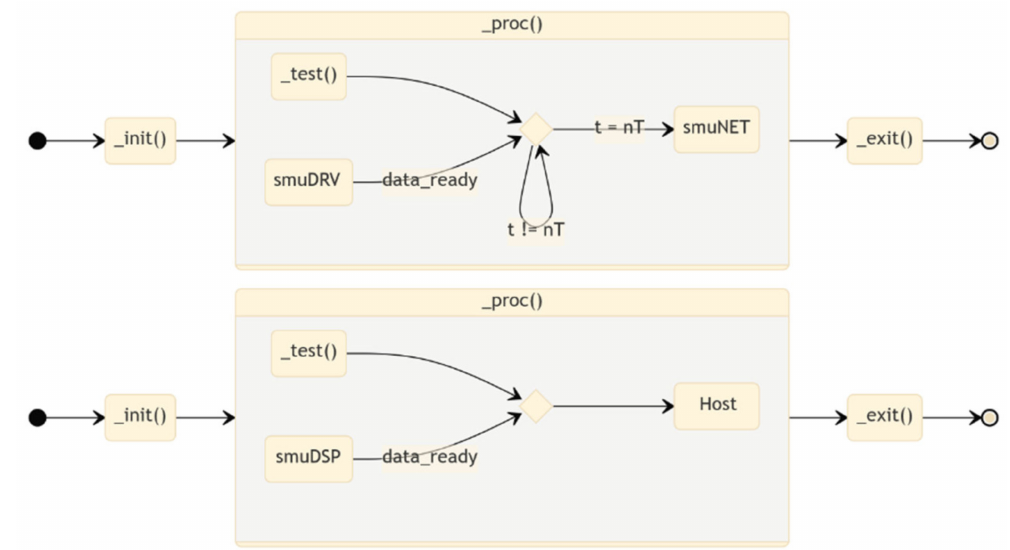
Figure 9. State diagram of the suds ( top ) and smuNET ( bottom )